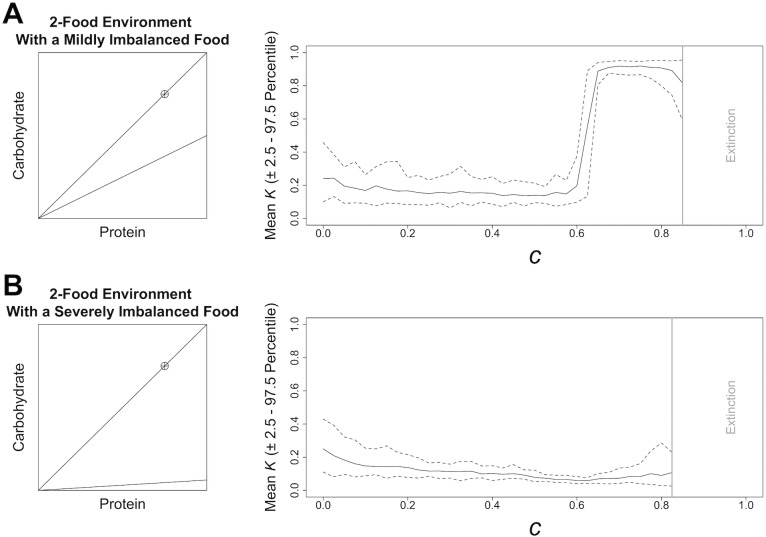
Model Results in Different 2-Food Environments.The effects of increasing competition, c (Equation 3), on the mean level of nutritional latitude, K, (and the 2.5th and 97.5th percentile; dashed line) that is stable under differing nutritional environments containing 2 foods. Data are based on 30 model runs. Data from levels of competition, above which the population could not consistently survive (i.e., extinction, given by a bold grey line), have been removed. A geometric visualisation of each environment is given; see Fig. 2 legend for details.